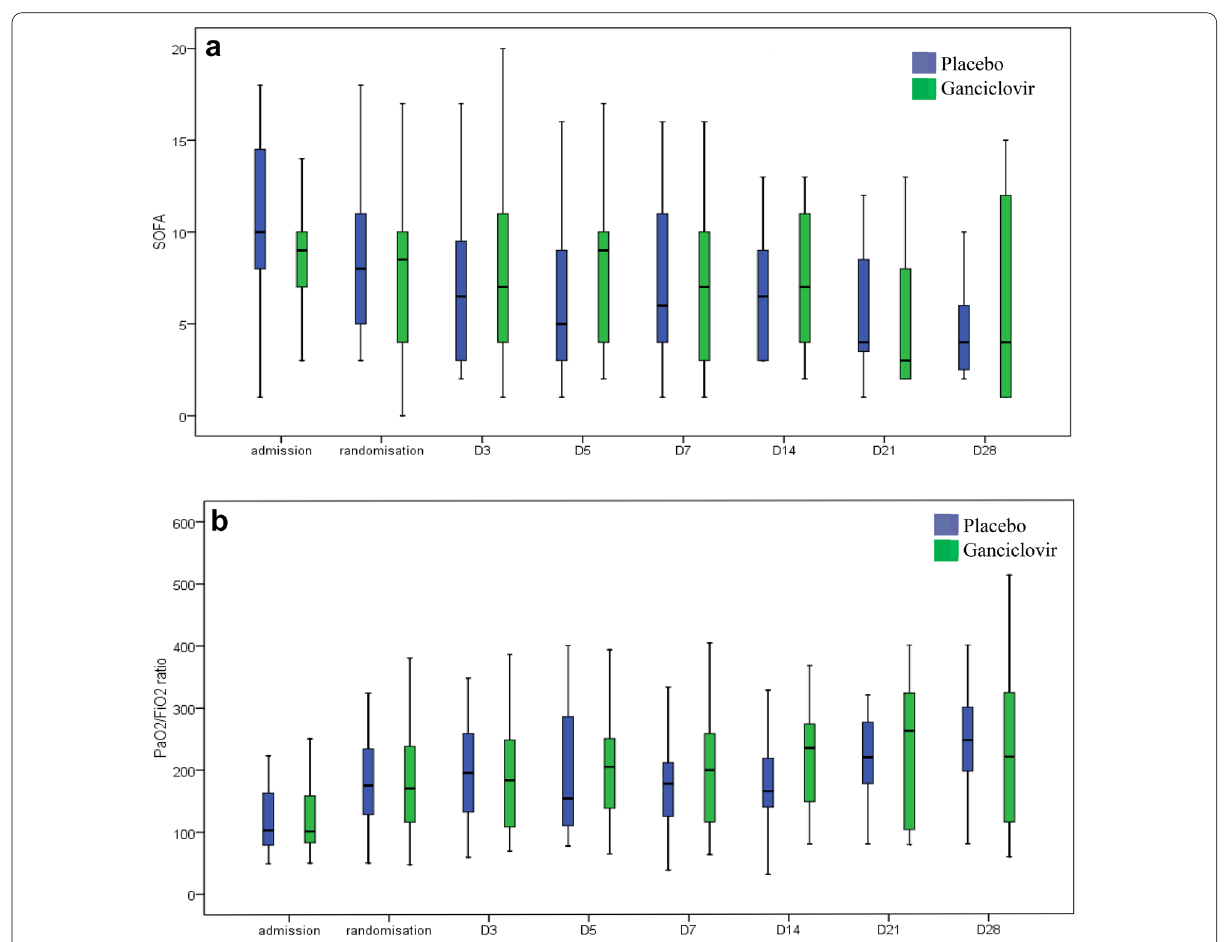
Fig. 3 a Kinetics of the Sequential Organ‑Failure Assessment (SOFA) score from Randomization to Day 28 According to Study Group. b Evolution of PaO2/FiO2 ratio from Randomization to Day 28 According to Study Group. PaO2/FiO2 denotes partial oxygen pressure in arterial blood/fraction of inspired oxygen